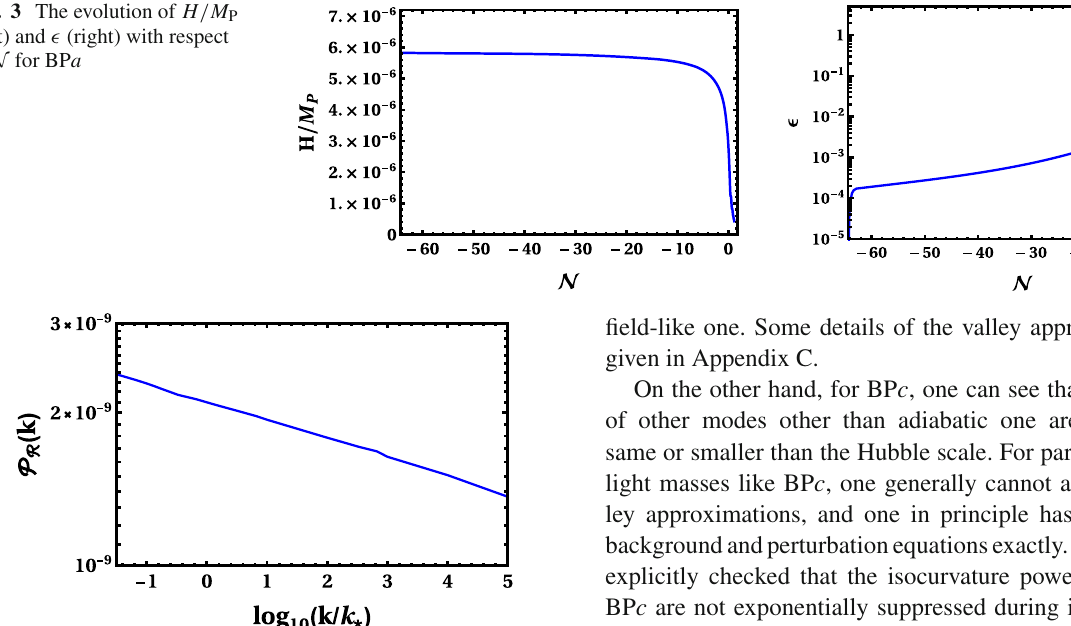
Fig. 4 The power spectrum P R ( k ) for the curvature perturbation as given in Eq. (65) for BP a for illustration